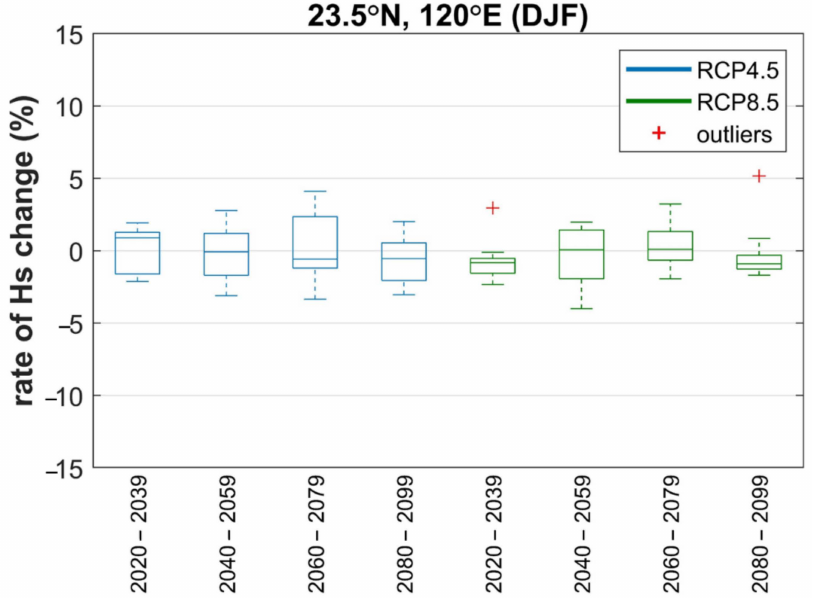
Figure 15. Box plot of rate of change in the seasonal mean of significant wave heights for each GCM, with respect to the reference period from 1980 to 2004 in the region of Taiwan in winter at 24 ◦ N, 120.15 ◦ E for various future periods (2020–2039, 2040–2059, 2060–2079, and 2080–2099) and scenarios (RCP4.5).